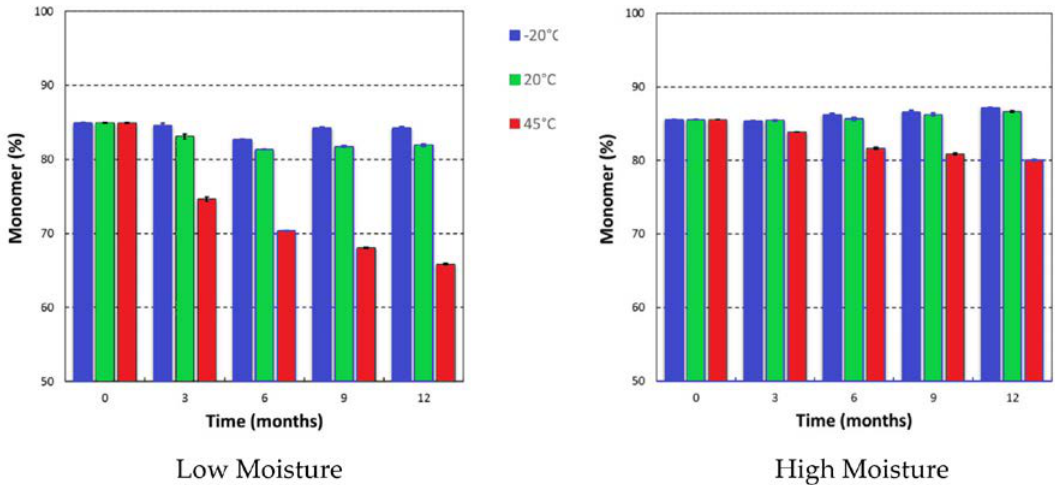
Figure 9. Diphtheria Binding Activity determined by ELISA for FD IgG 50 mg/mL in “low” or “high” moisture cycle batches over 12 months of storage. Error bars represent 95% confidence intervals.